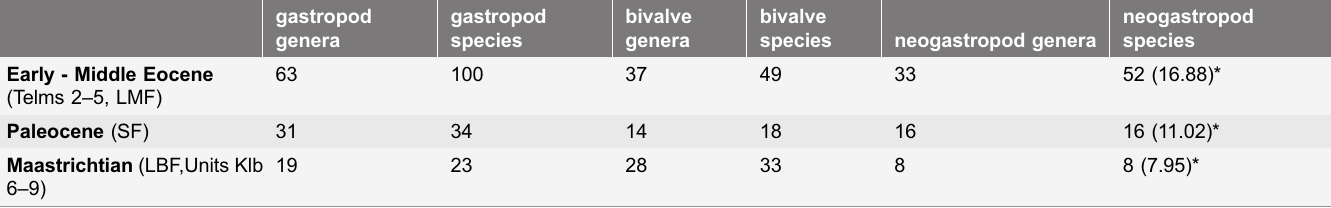
Owing to the fact that they were collected over a number of years and by different groups it was not possible to sample-standardise the general collections of gastropods and bivalves with any degree of accuracy. However, the neogastropod collections are better constrained and reasonably accurate estimates of numbers of individuals can be made for all species. Therefore it is possible to use rarefaction to at least partially sample-standardise for the fact that the three time bins are of unequal stratigraphic thickness and temporal duration. * represents values for rarefaction to 100 individuals, i.e. E(S 100 ). Total numbers of neogstropods for the three time bins are: Maastrichtian 5 344; Paleocene 5 343; Early - Middle Eocene 5 3483. Key: LBF 5 Lo´pez de Bertodano Formation; SF 5 Sobral Formation; LMF 5 La Meseta